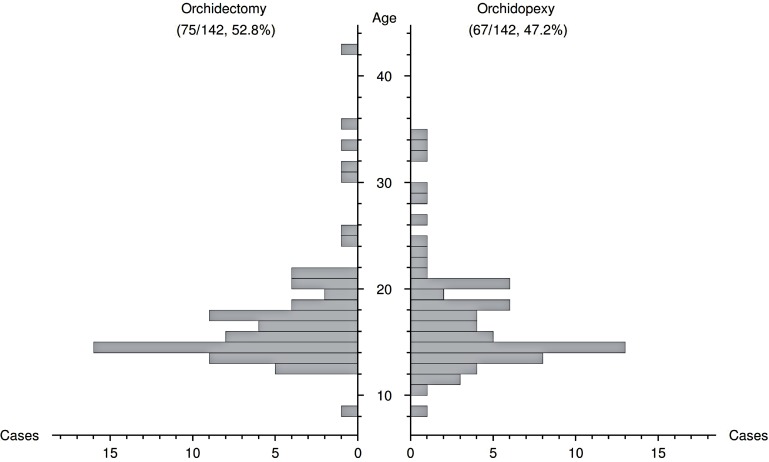
Age distribution of patients either submitted to orchidopexy or orchidectomy.